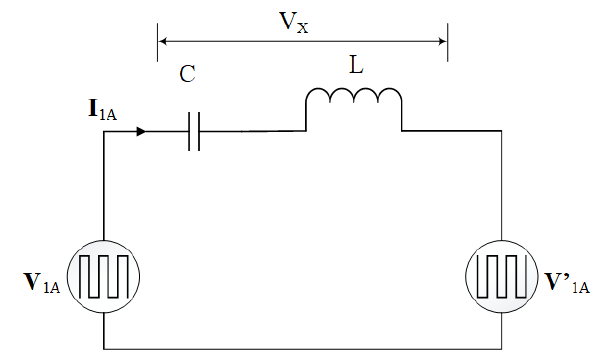
Figure 8. Equivalent circuit of the 3P-DABSRC